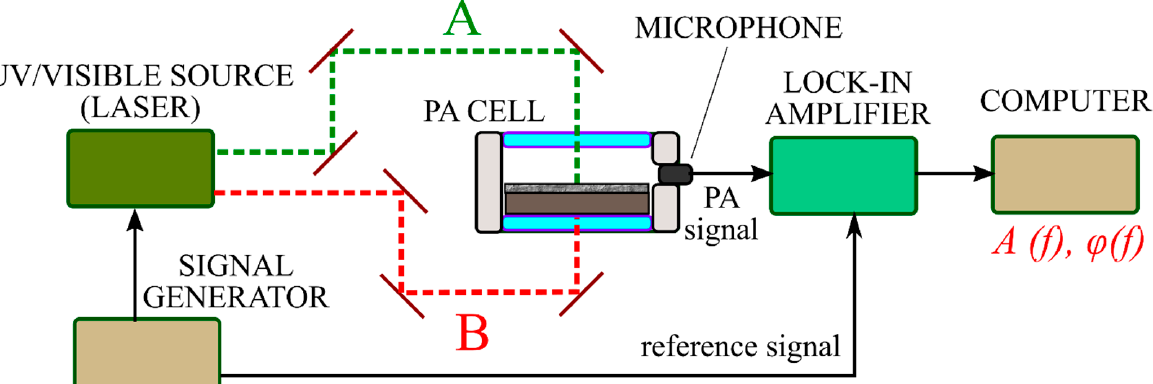
Figure 4. Typical photoacoustic setup for the thermal and optical property characterization of layered semiconductor materials. Case A corresponds to the front-surface illumination configuration; case B refers to the rear-surface illumination configuration.